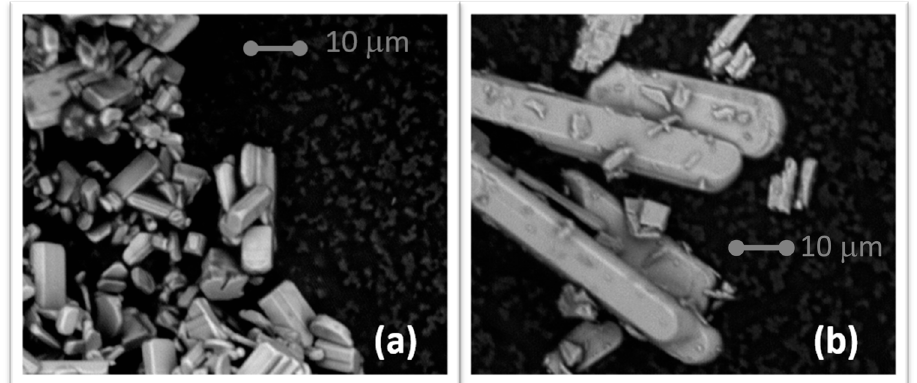
Figure 3. Scanning electron microscopy (SEM) micrographs of the as-synthesized samples: ( a ) α -NaMnO 2 ; ( b ) β -NaMnO 2 .